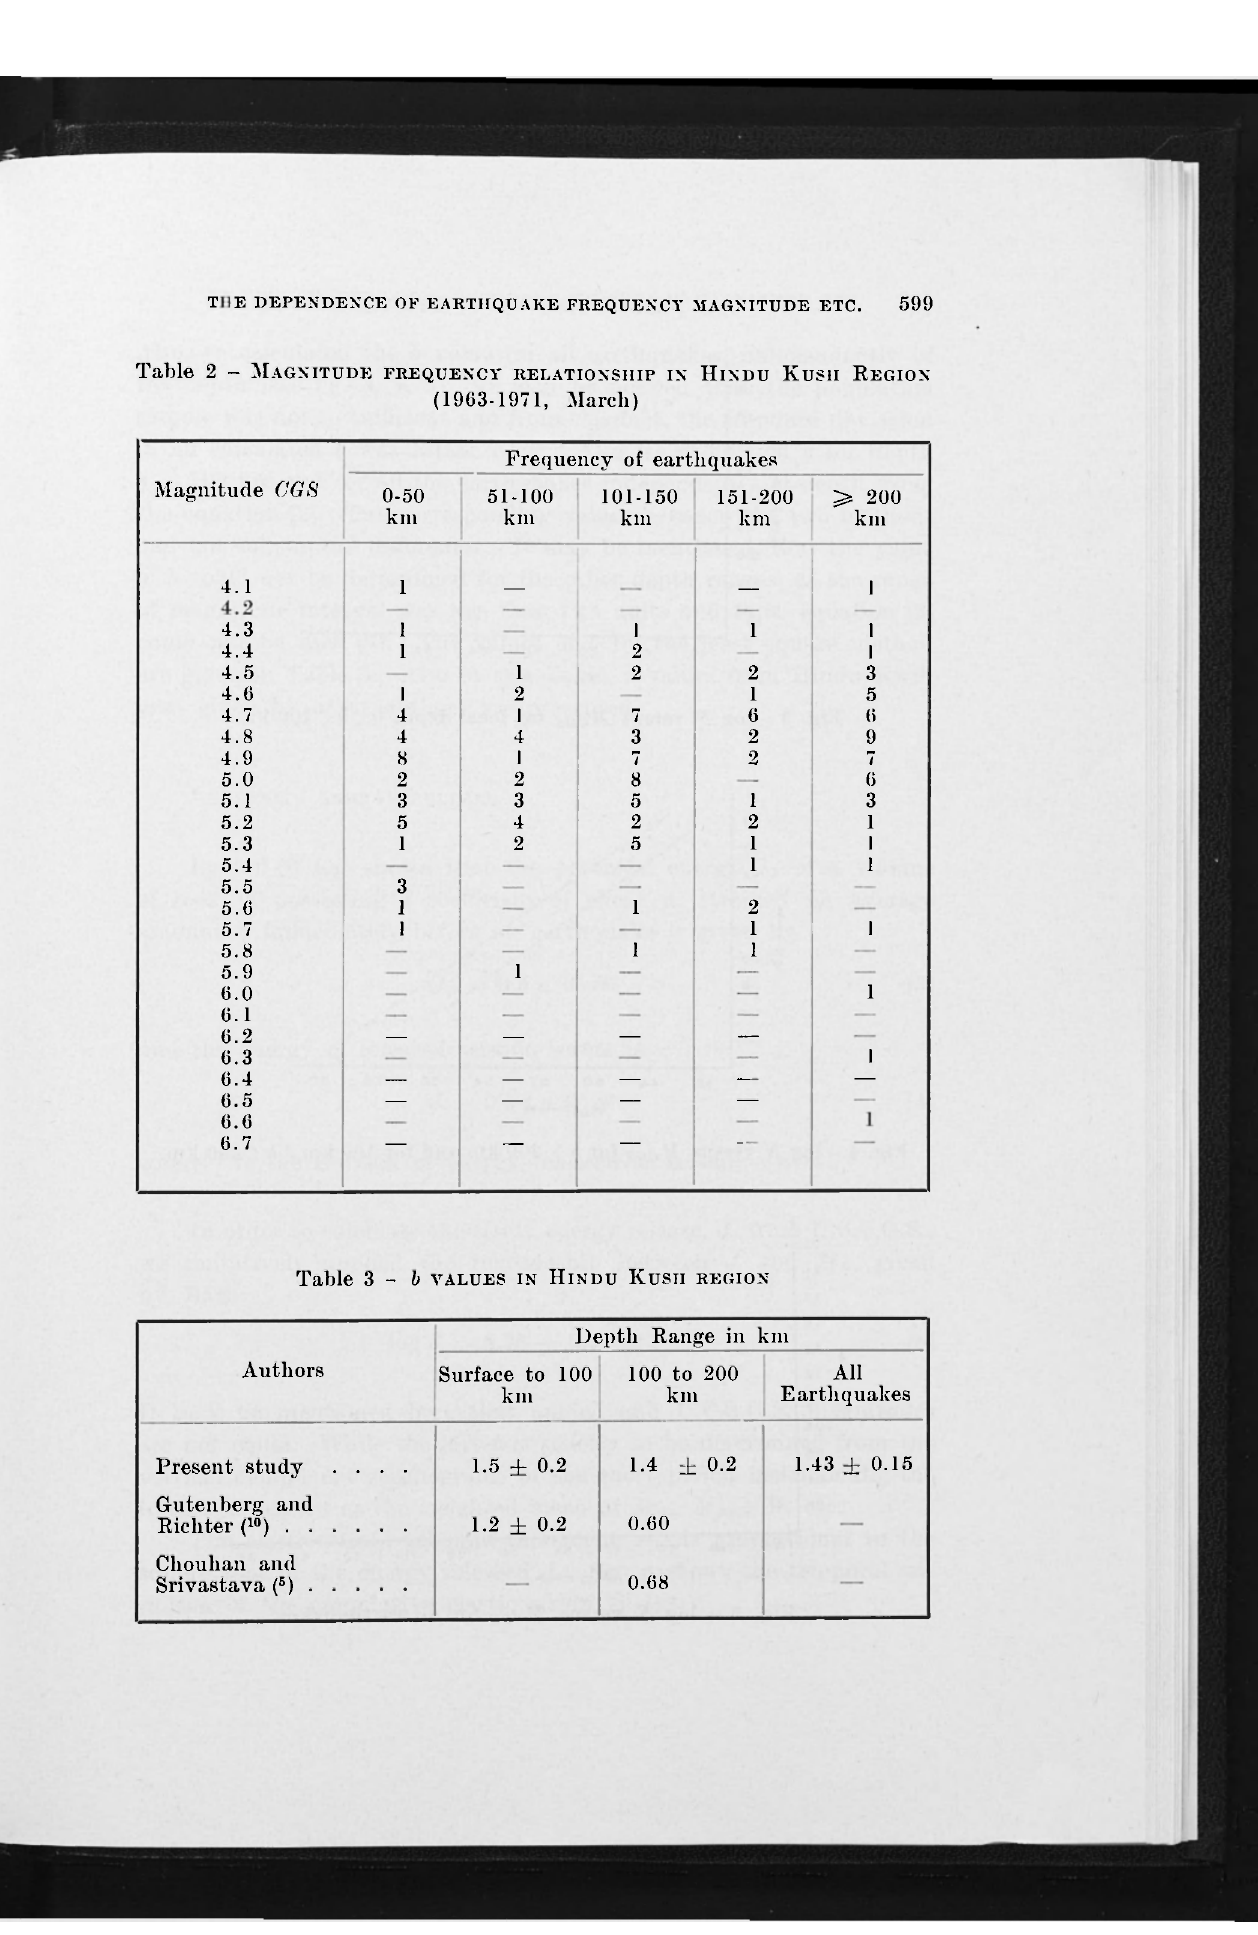
Table 3 - b VALUES IN HINDU KUSII